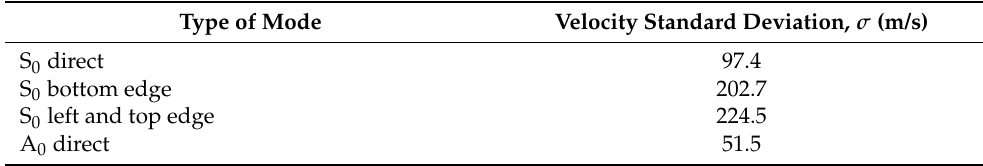
Table 1. The standard deviation of the estimated phase velocities for different GW mode